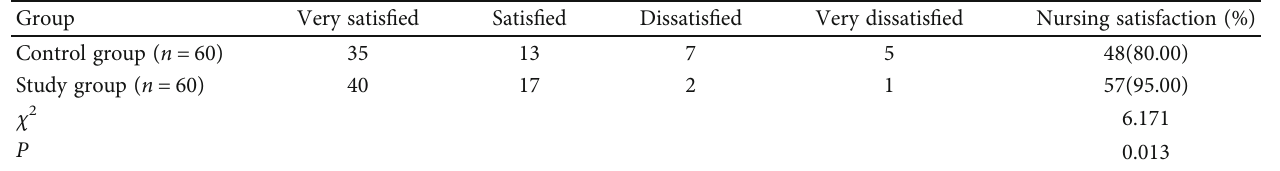
Table 10: Comparison of nursing satisfaction between the two groups (n,